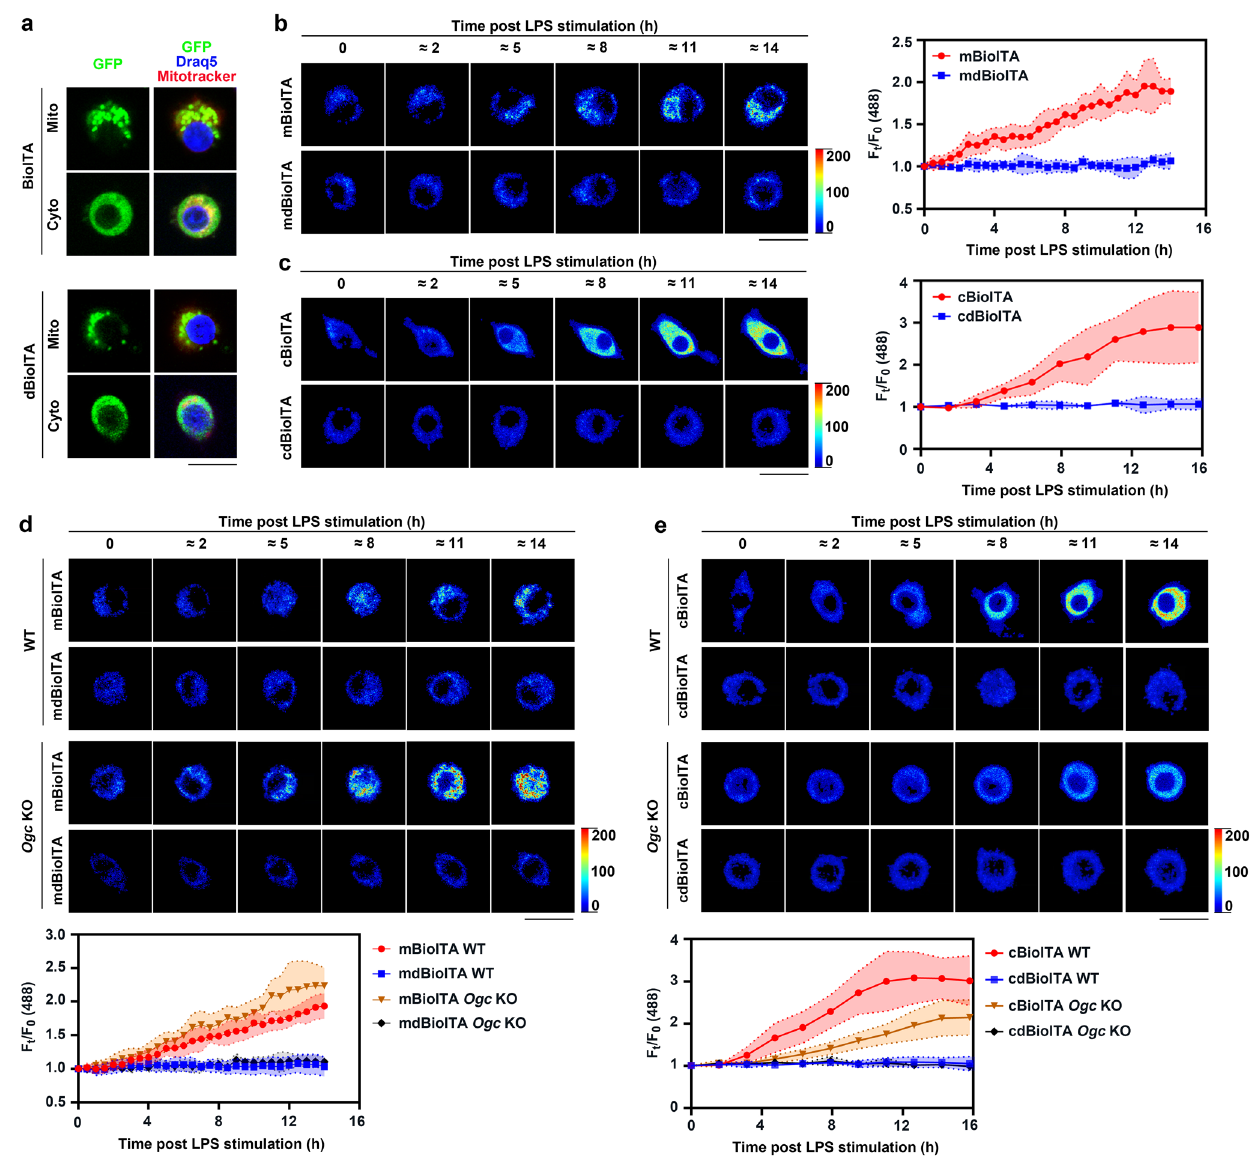
Fig. 3 | BioITA images itaconate levels in mitochondria and cytosol of living macrophages. a Representative live images of RAW264.7 cells stably expressing BioITAor dBioITAcontaining mitochondrial (mBioITAand mdBioITA) or cytosolic (cBioITA and cdBioITA) localization sequence. dBioITA, dead BioITA; mBioITA, mitochondrial BioITA; cBioITA, cytosolic BioITA; mdBioITA, mitochondrial dBioITA; cdBioITA, cytosolicdBioITA.Mitochondrialmarker Mitotracker CMXRos, red; BioITA, green; nuclear marker Draq5, blue. Scale bar, 20 μ m. The experiments were repeated three times independently with similar results. b , c RAW264.7 cells stably expressing mitochondrial ( b ) or cytosolic ( c ) BioITA was stimulated with or without LPS (10ngml – 1 ). Representative pseudo-color images were captured ( b , c , left panels) and fl uorescence intensity was quantitated at indicated time